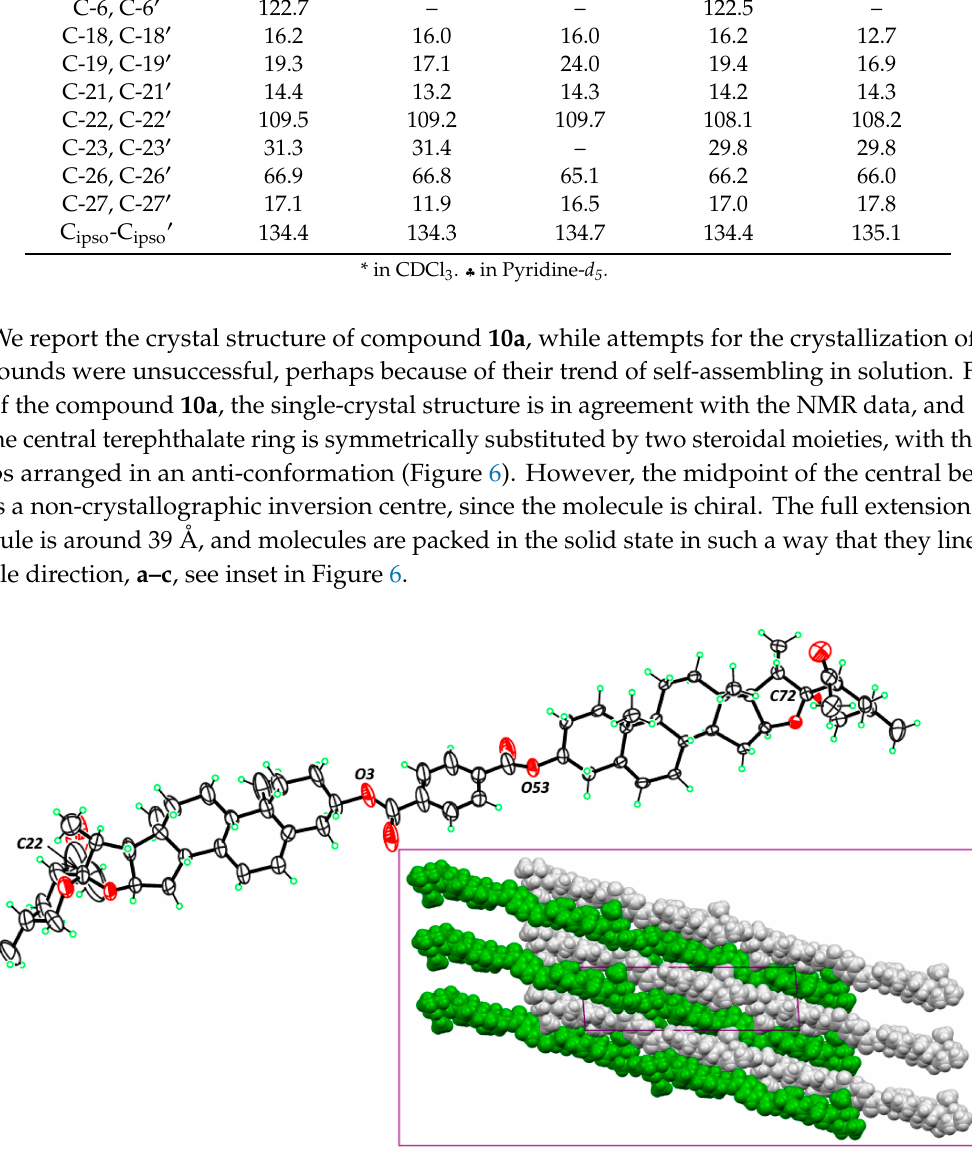
Table 4. Selected 13 C-NMR signals of the 8a–c and 10a–b in ppm.